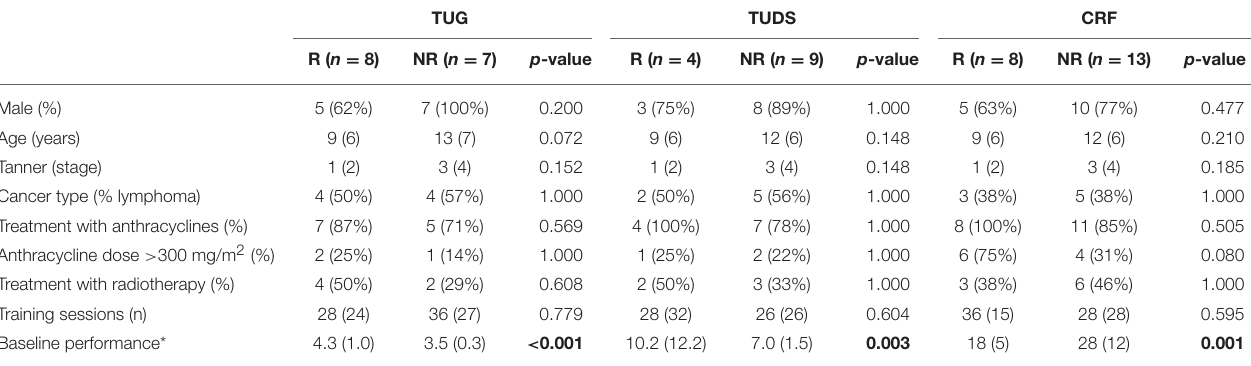
TABLE 4 | Differences between responders (R) and non-responders